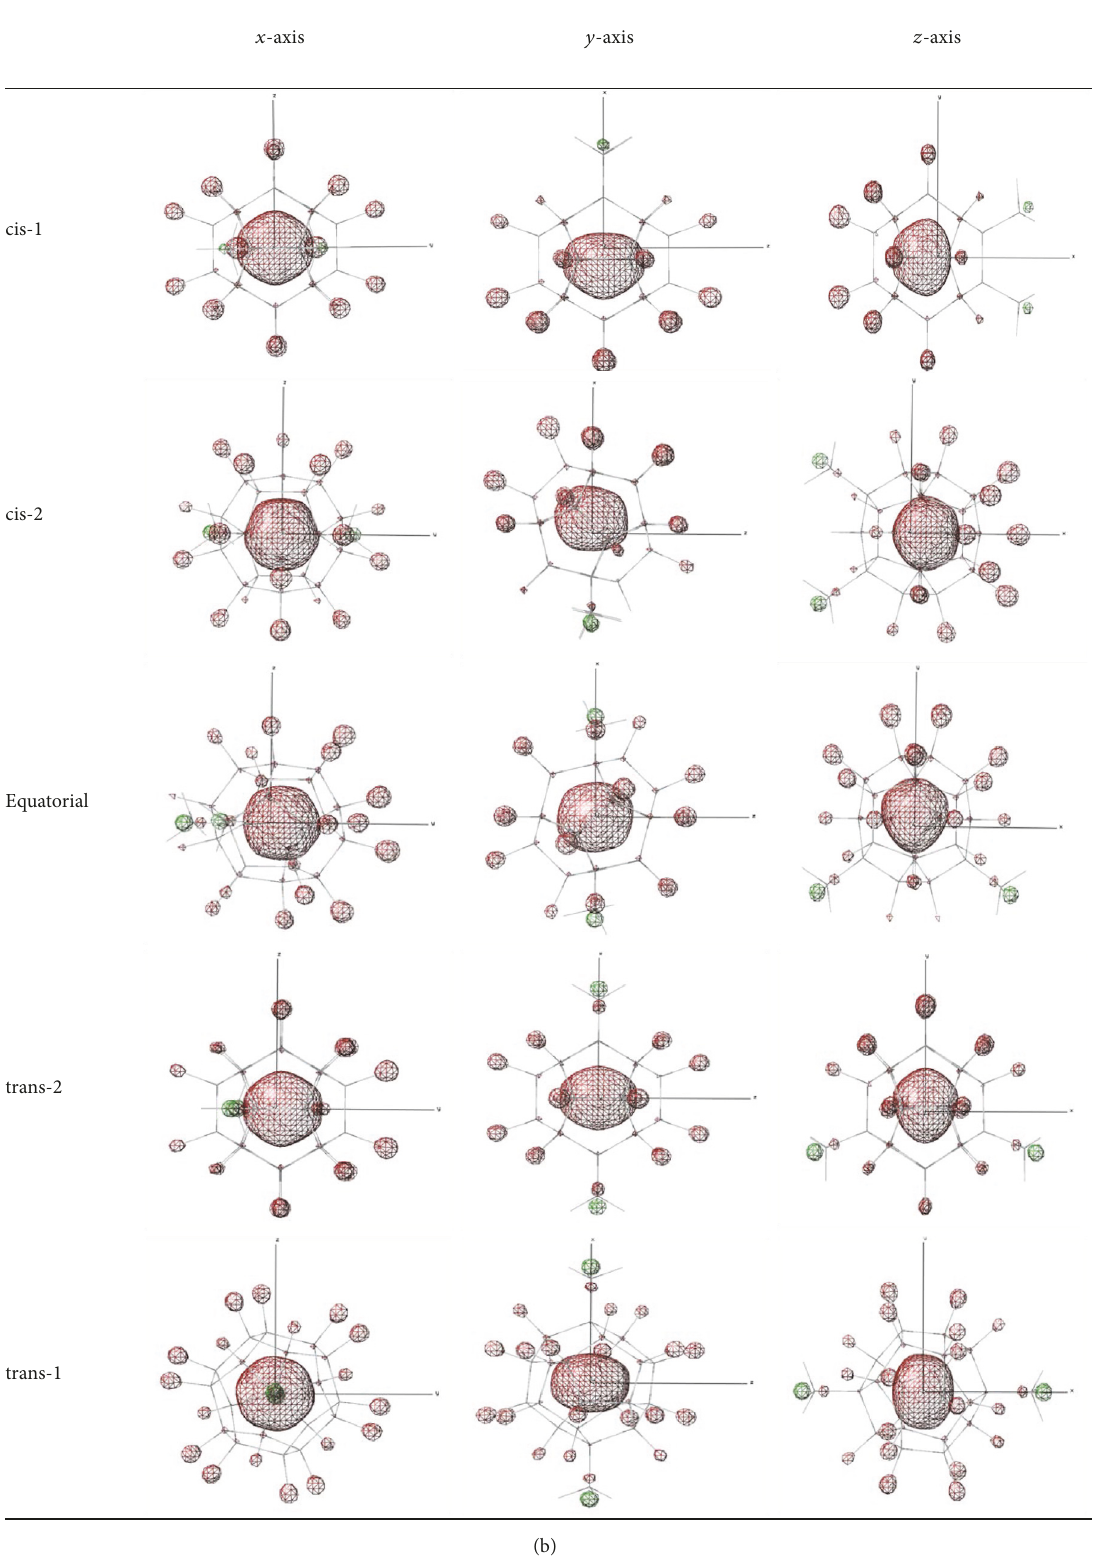
Figure 2: The (a) HOMOs and (b) LUMOs of the fully optimized geometries of the five C 20 H 18 (CH 3 ) 2 derivatives using B3LYP/6-31G(d,p) calculations. Here 𝑋 -, 𝑌 -, and 𝑍 -axis represent the frontier orbitals, looking from 𝑥 , 𝑦 , and 𝑧 direction, respectively. The HOMOs of C 20 H 18 (CH 3 ) 2 derivatives (isovalue = 0.05). trans-2 (HOMO: − 7.08 eV) and the others (HOMO: − 7.05); C 20 H 20 (HOMO: − 7.09eV). The LUMOs of C 20 H 18 (CH 3 ) 2 derivatives (isovalue = 0.05). Five dimethyl derivatives (LUMO: 0.98 eV); C 20 H 20 (LUMO: 0.90